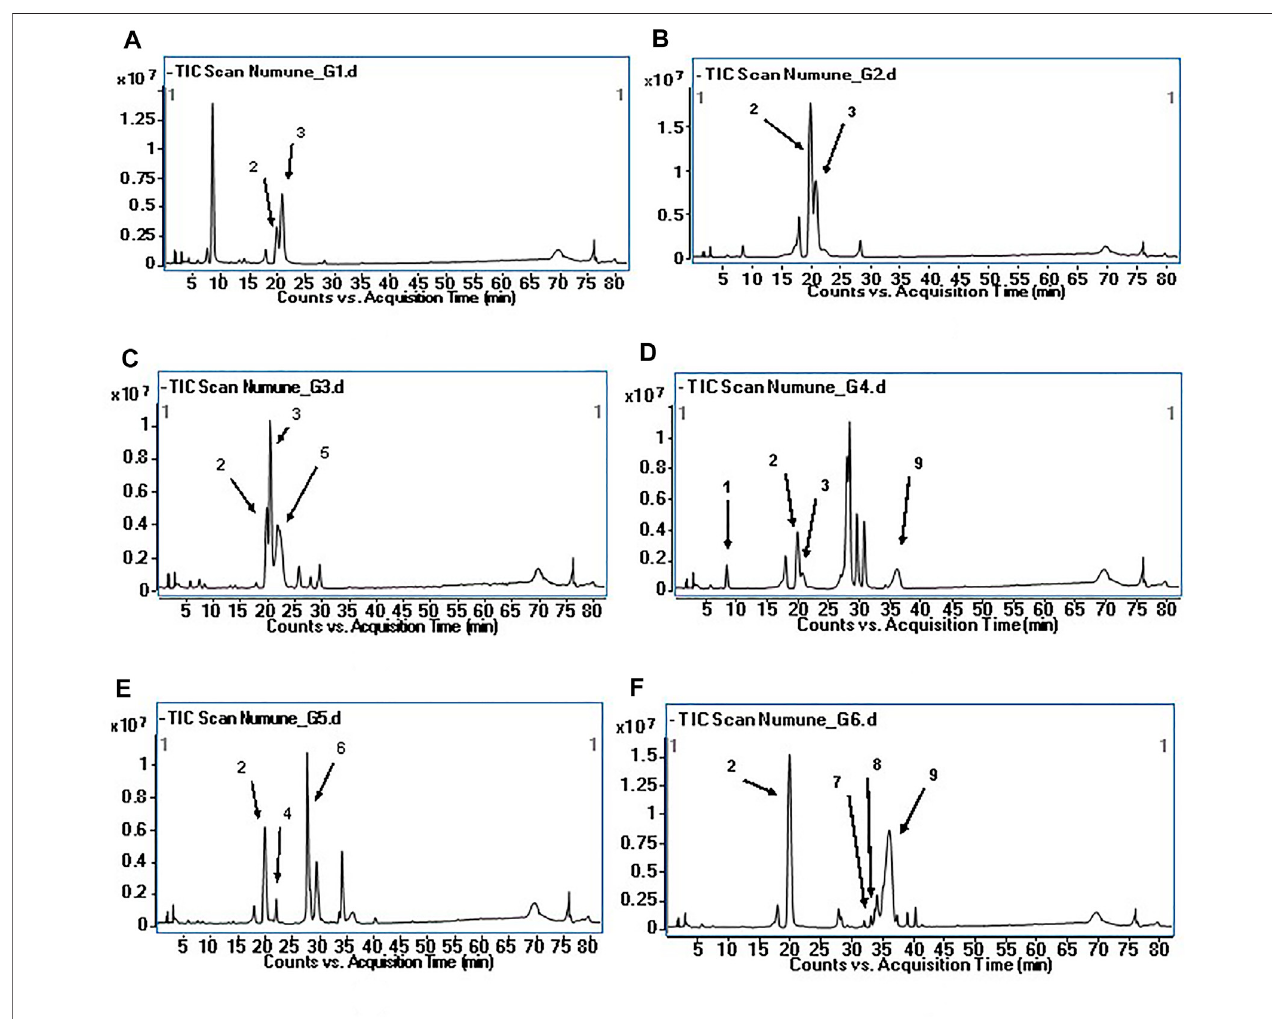
FIGURE3| Totalionchromatogram(TIC)ofthecompoundsinGcodedsub-fractions (A) :TICoftheG1codedsub-fraction; (B) :TICoftheG2codedsub-fraction; (C) : TIC of the G3 coded sub-fraction; (D) : TIC of the G4 coded sub-fraction; (E) : TIC of the G5 coded sub-fraction; (F) : TIC ofthe G6coded sub-fraction; The numbers for the molecules indicated on the chromatograms are given in Table 7